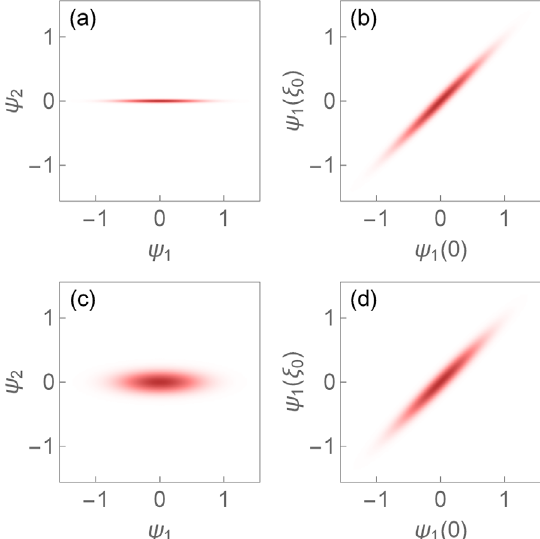
probability distribution ρ ( ψ 1 ð r Þ ; ψ 2 ð r Þ ) computed at time t ¼ 2 . 0 ps for G 10 − 5 (a) and t ¼ 1 . 0 ps for G 1 ¼ G 2 ¼ 1 ¼ G 2 ¼ 10 − 2 (c) in the fast cooling limit t 0 . Regions of higher m ¼ value of ρ appear redder. Panels (b),(d) show the two-point probability ρ ( ψ 1 ð 0 Þ ; ψ 1 ð ξ 0 Þ ) distributions for the same two cases. 1 . 0 ; 1 . 1 Þ , ; α 2 The common parameters used are ð α 1 L L Þ ¼ ð ð γ 1 ; γ 2 Þ ¼ ð 2 ; 1 Þ ps − 1 , ξ 0 i ¼ ξ 0 , and D ¼ 3